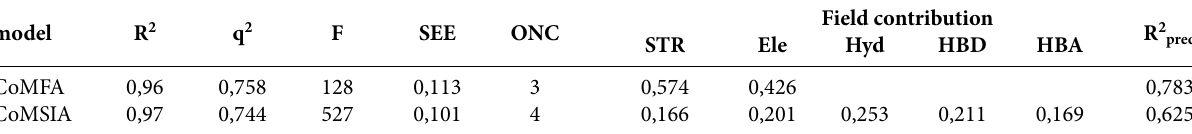
Table 1. Calculated datsa for the 3D-QSAR model model SEE